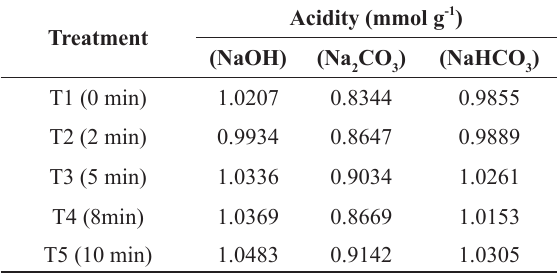
Acidity of activated carbons depending on treatment.